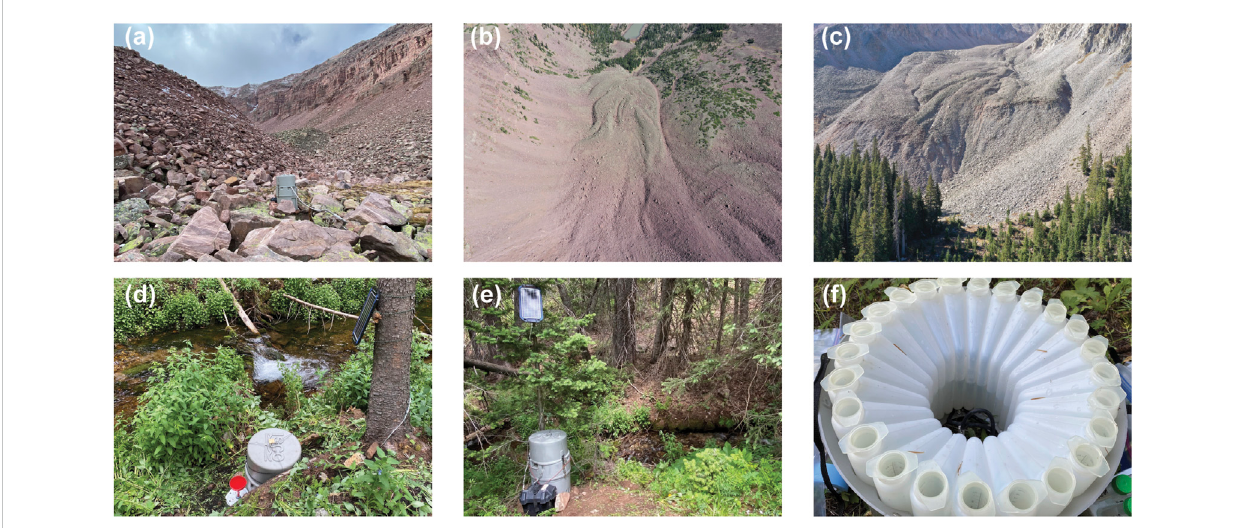
FIGURE 2 Photographsofstudysitesandmethodology. (A) PhotographoftheautomatedwatersamplerdeployedattheterminusoftheRG-1rockglacier. (B) Photograph of the RG-2 rock glacier collected from an uncrewed aerial vehicle (UAV). (C) Oblique photograph of the terminus of the RSC rock glacier in the La Sal Mountains from a UAV. (D) Photograph of the GB water sampler in the La Sal Mountains. The sampler drew water directly from the stream and thebattery system was charged bythesolar panel mounted on thetree.The red funnel isthetop of theprecipitation sampler. (E) Photograph ofthe WF sampler along the Wet Fork Mill Creek (background) in the La Sal Mountains. (F) Photograph showing the carousel of 24, 500-mL bottles within the water sampler.